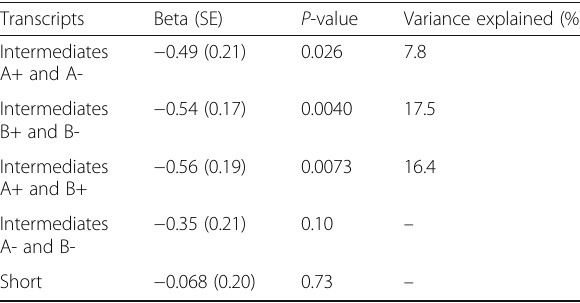
Table 1 rs9349379 is an eQTL for PHACTR1